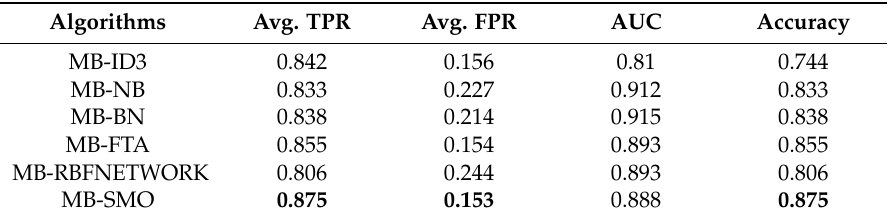
Table 5. Results of different classifiers with MB feature